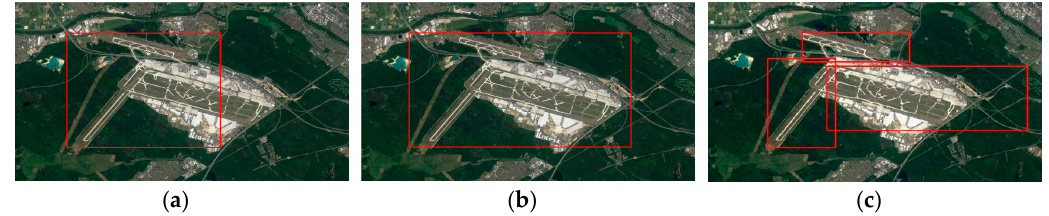
Figure 7. True detection results of different methods. ( a ) Faster R-CNN; ( b ) proposed method; ( c ) LSD + AlexNet. [Image courtesy of Google Earth].